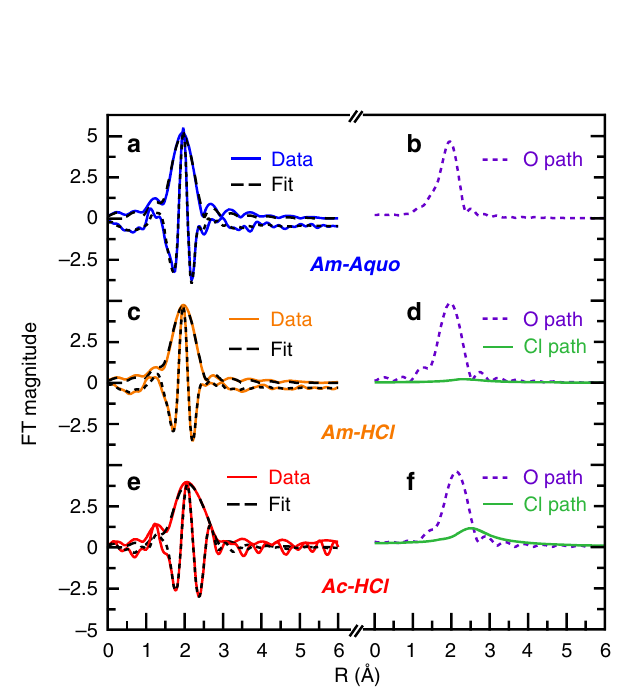
Figure 3 | Fourier Transform of the Ac III and Am III k 3 -EXAFS. ( a ) Fourier Transform of k 3 -EXAFS spectra from Am-Aquo (0.11M HO 3 SCF 3 ) in blue trace and its fit in dashed black trace. ( b ) Oxygen path contribution in the fitted data in dashed purple. ( c ) Fourier Transform of k 3 -EXAFS spectra from Am-HCl (11M HCl) in red trace and its fit in dashed black trace. ( d ) Oxygen and chlorine paths contribution in the fitted data in dashed purple and green solid trace, respectively. ( e ) Fourier Transform of k 3 -EXAFS spectra from Ac-HCl (11M HCl) in red trace and its fit in dashed black trace. ( f ) Oxygen and chlorine paths contribution in the fitted data in dashed purple and green solid trace,